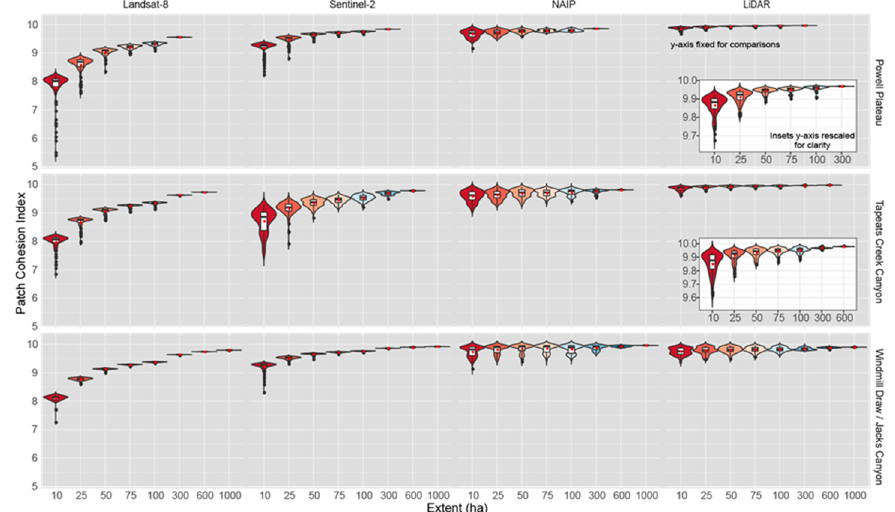
Figure 7. Violin plots (colored by extent and depicting probability density of the data at different values smoothed by a kernel density estimator), box-and-whisker plots (black and white) and mean (red dot) for patch cohesion index (%). Patch cohesion index describes the physical connectedness of patches of canopy cover for each landscape and data product (Landsat-8 30 m, Sentinel-2 10 m, NAIP 1 m, LiDAR 1 m), and across multiple spatial extents. Insets with rescaled y-axis provided for clarity. Table 6. Patch cohesion (PC) index measuring the physical connectedness of patches of canopy cover for each landscape and data product (Landsat-8 30 m, Sentinel-2 10 m, NAIP 1 m, LiDAR 1 m), and across spatial extents. Mean values and standard error (SE) are shown.